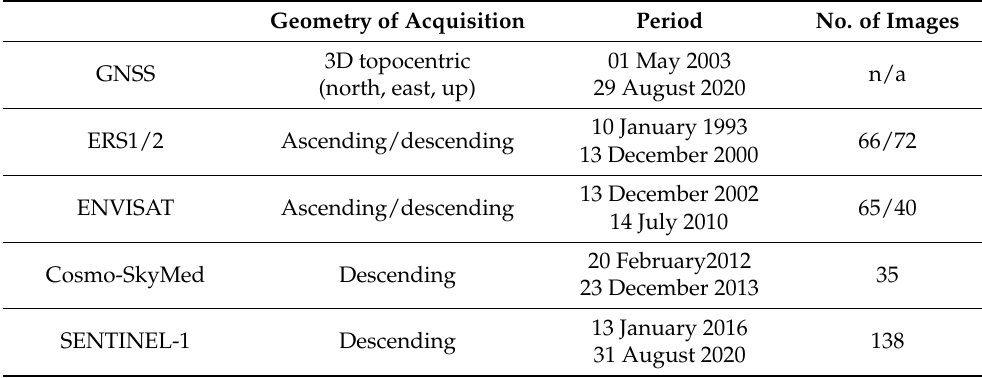
Table 2. Geodetic data sets used in this study. Geometry of Acquisition Period No. of Images 3D GNSS